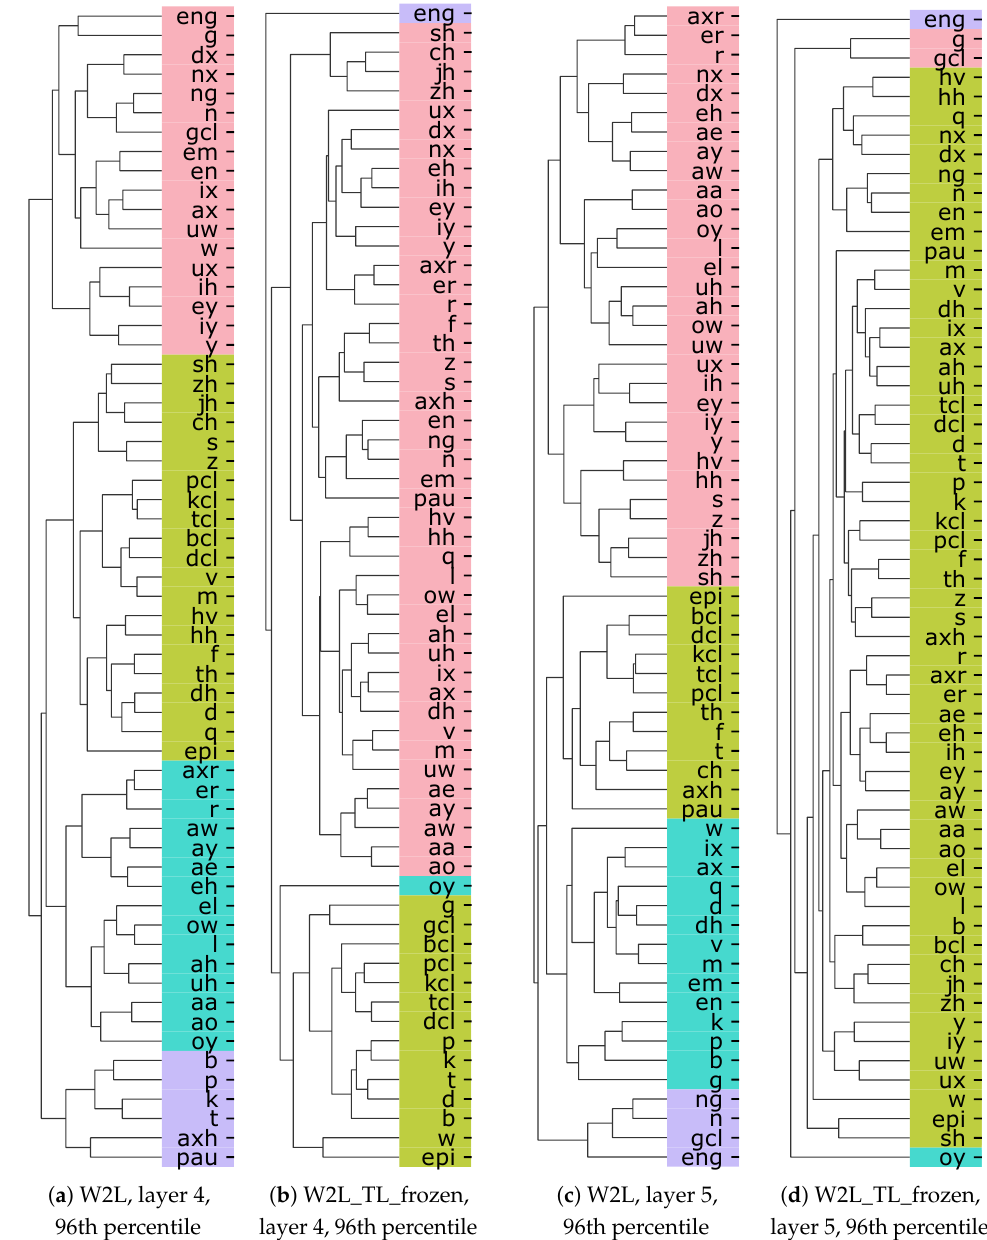
Figure 7. Clustering result for W2L ( a , c ) and W2L_TL_frozen ( b , d ) compared between layer 4 ( a , b ) and 5 ( c , d ) at the percentile with highest change of Silhouette score from layer 4 to layer 5 Clustering assignment is shown by coloring. Colors of clusters in different subfigures do not represent mapping of the corresponding clusters. Pairwise distances are visualized in Figure 6. The W2L model, in contrast, showed more distinct subclusters in both the 4th and 5th layers. The number of clusters is the same in both layers but the sets of phonemes being assigned to the same cluster is substantially different. 35.4% of phoneme pairs change from being assigned to the same cluster to being in different clusters or vice versa. At the same time, distances between SNAP in the W2L model are much higher and vary more than in the transfer learning model. Phoneme clusters in the W2L model indicate that the model encodes high-level concepts of similar sounds. For example, the red cluster in the 5th layer (Figures 6c and 7c) contains most